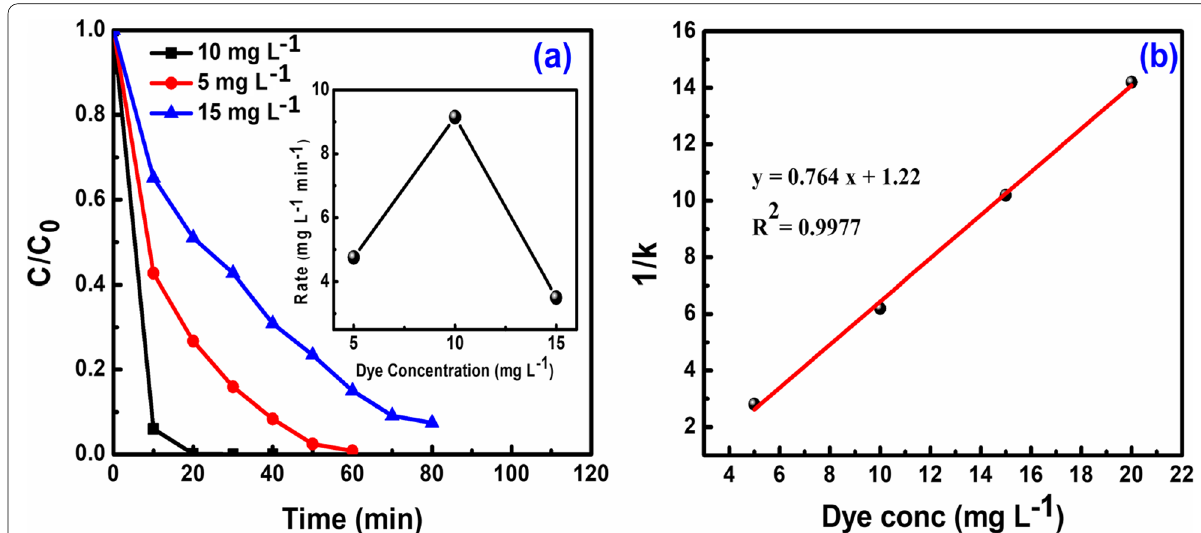
Fig. 15 a The effect of initial dye concentration on AB 10 B degradation. b LH model for AB 10B dye concentration